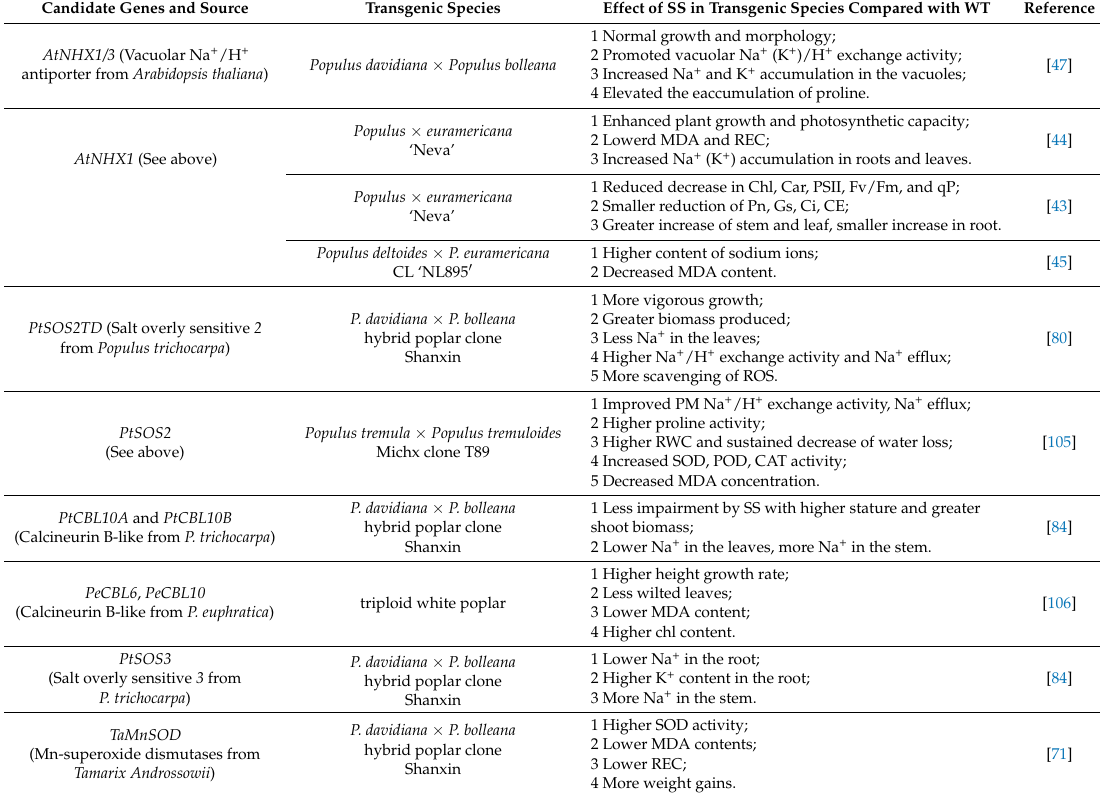
Table 1. Candidate genes for improving salt tolerance in Populus . Candidate Genes and